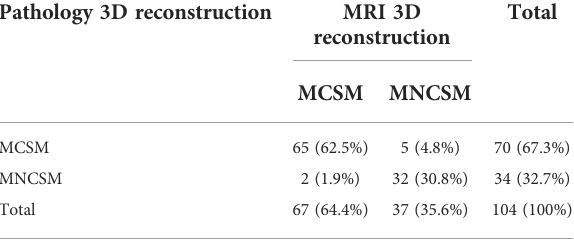
TABLE 5 The modi fi ed shrinkage classi fi cation modes after NAT between MRI and pathology 3D reconstruction. Pathology 3D reconstruction